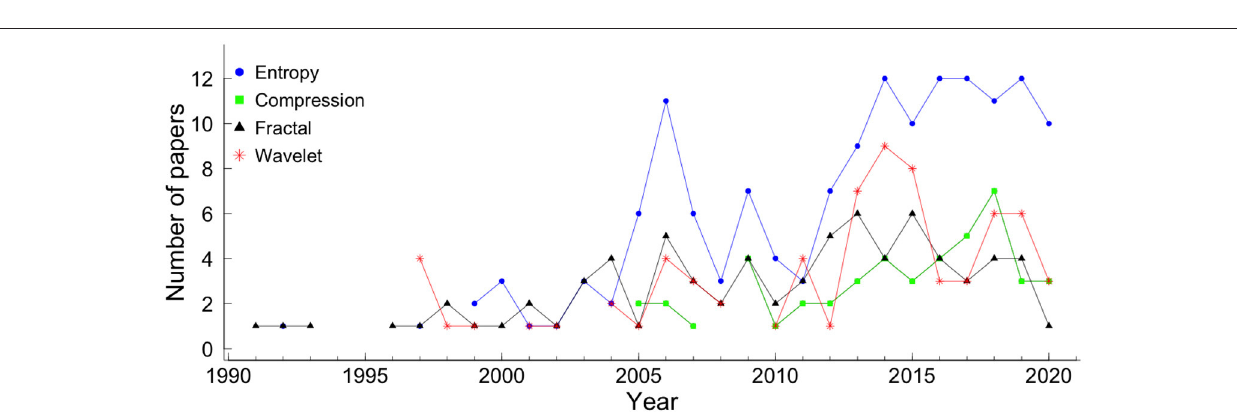
42, 49, 50), Kolmogorov-Sinai entropy (30),